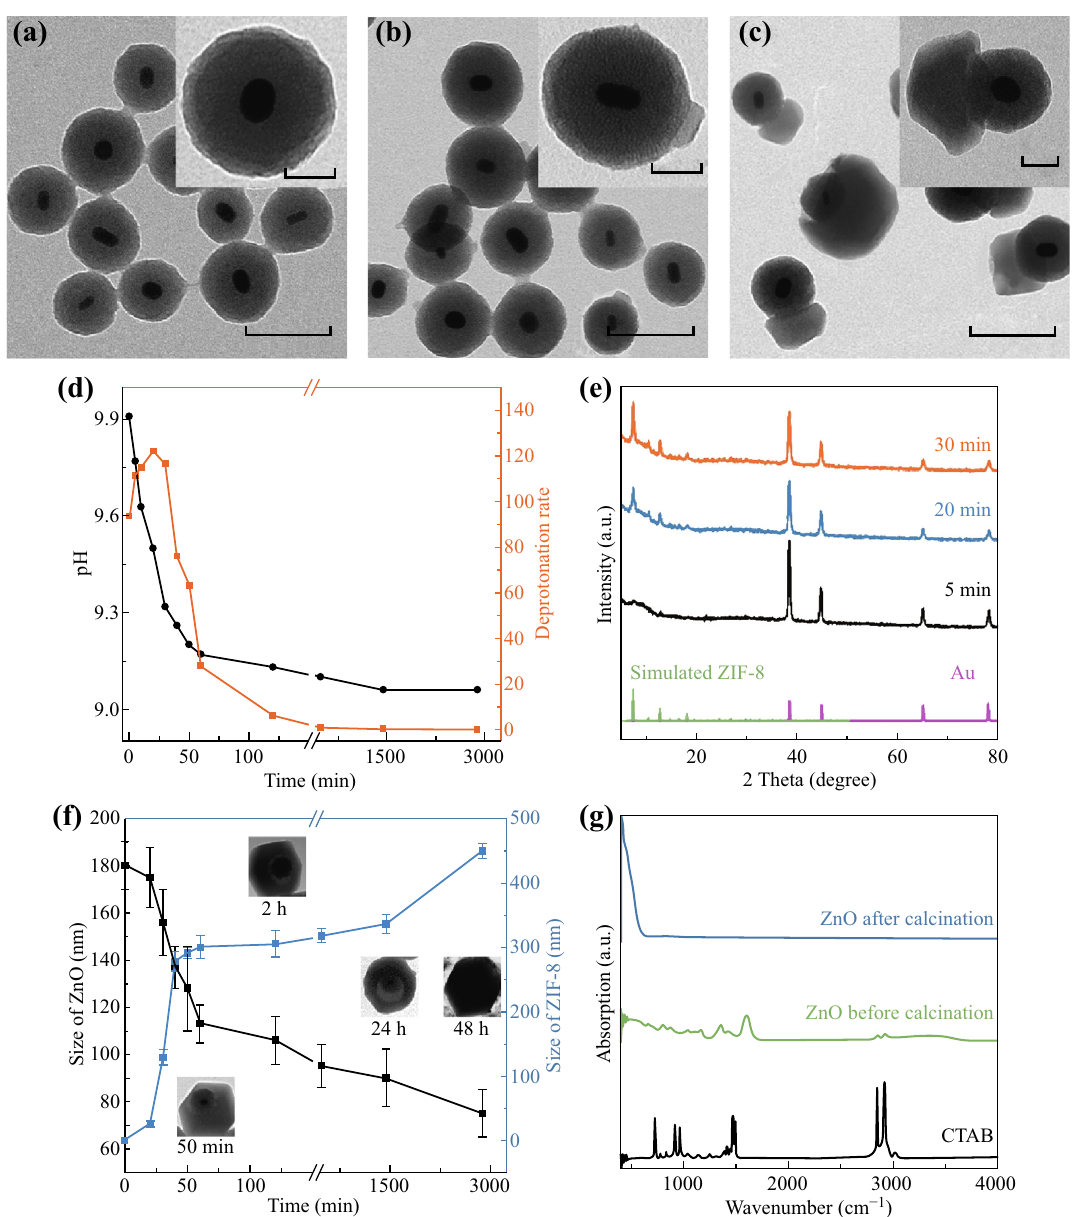
Fig. 3 TEM images of Au@ZnO@ZIF-8 obtained at a 5 min, b 20 min, c 30 min; d pH and deprotonation rate plots versus time; e corresponding XRD patterns of samples in a , b , and c ; f plots of Au@ZnO and Au@ZnO@ZIF-8 size versus time, insets are the represented TEM images of the products obtained at specific times; g FTIR absorption spectra for CTAB, Au@ZnO before calcination and after calcination at 300 (cid:3) C in air for 2 h. Scale bars in a , b , and c represent 200 nm. Scale bars in the insets represent 60